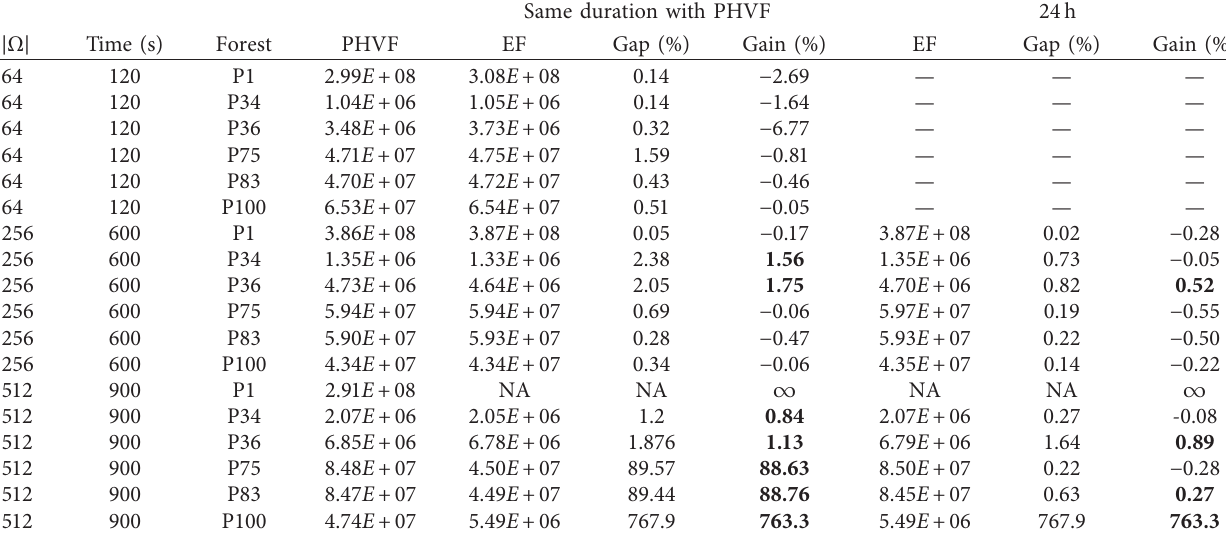
Table 10: Comparison of solutions from PHVF and the extensive